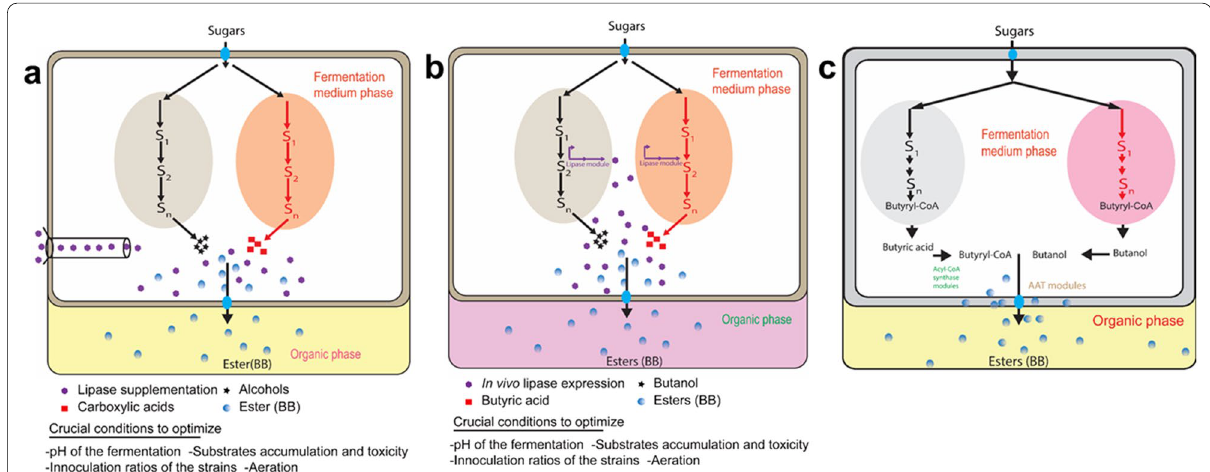
Fig. 3 Schematic representation of possible microbial consortium approaches for efficient BB biosynthesis. Light grey color and light orange in ( a ) and ( b ) represent carboxylic acids- and alcohols-producing strains, respectively. The bright purple color ( a ) represents commercial lipase enzymes supplementation while in ( b ) stands for lipase heterologously expressed in one or both strains as an alternative to undergo esterification reaction. c Approach using a cognate consortium comprising butanol-producing strain and butyric acid-producing strain. Butyrate produced in the medium is converted by butyryl-CoA synthase into butyryl-CoA precursor. AAT represents alcohol acyltransferases involved in the last step to catalyze butyryl-CoA and butanol substrate into biosynthetic